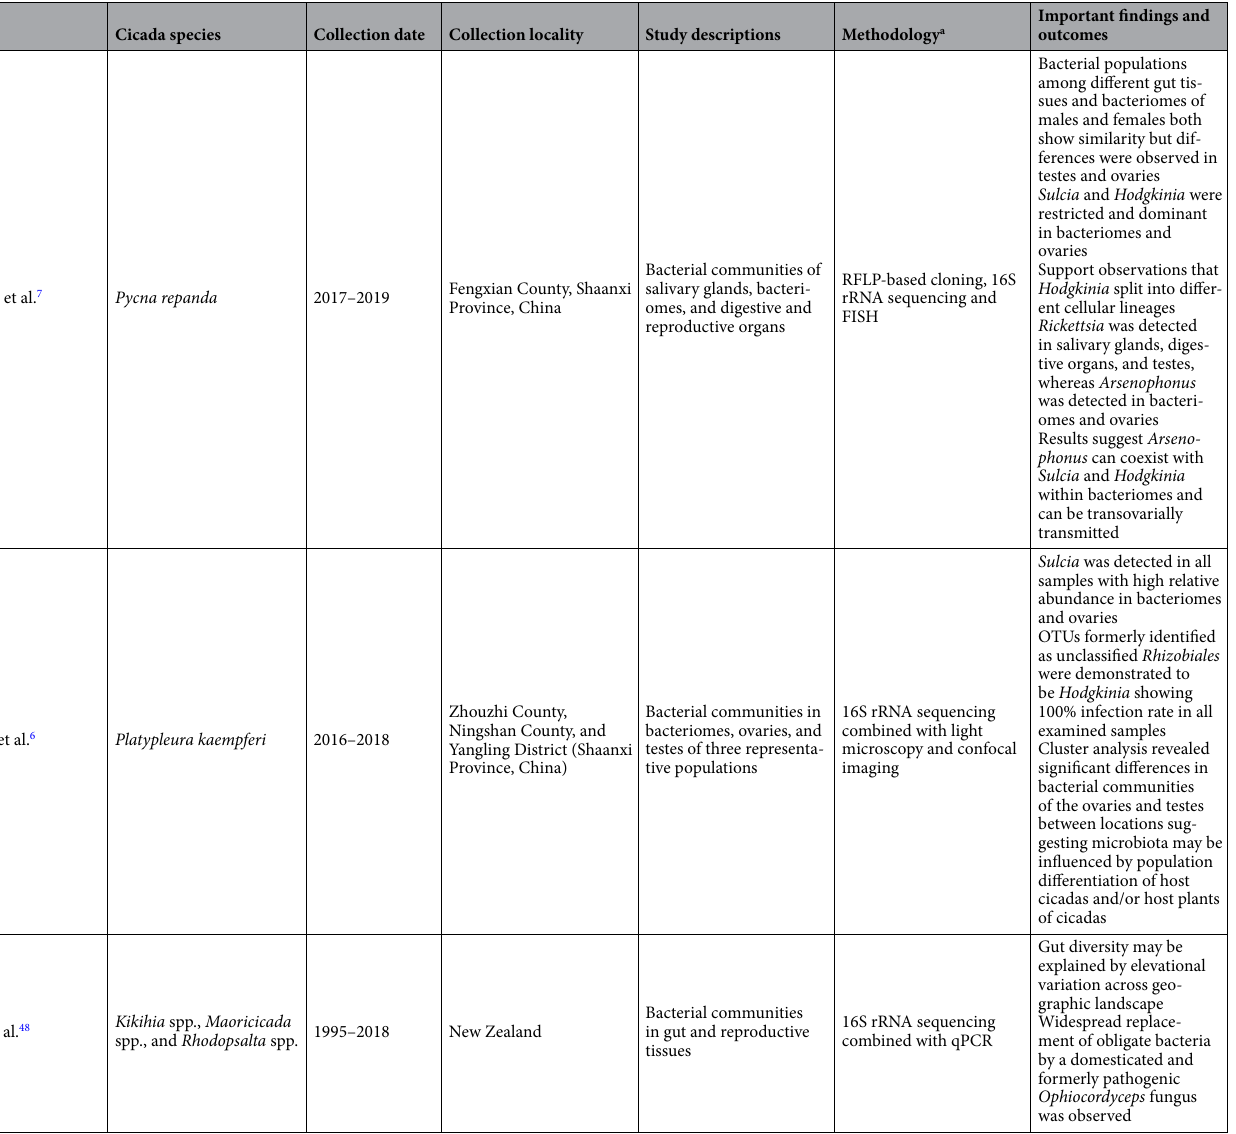
Table 2. Microbiota associated with cicadas. Studies are sorted by year of publication. a EF1α